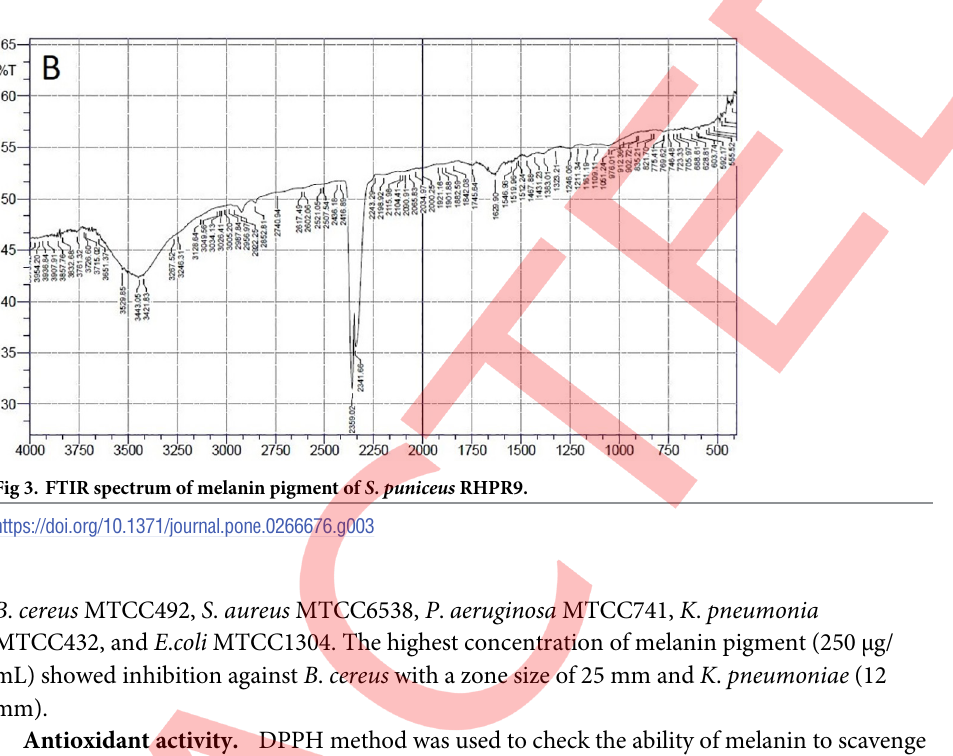
Fig 3. FTIR spectrum of melanin pigment of S . puniceus RHPR9.